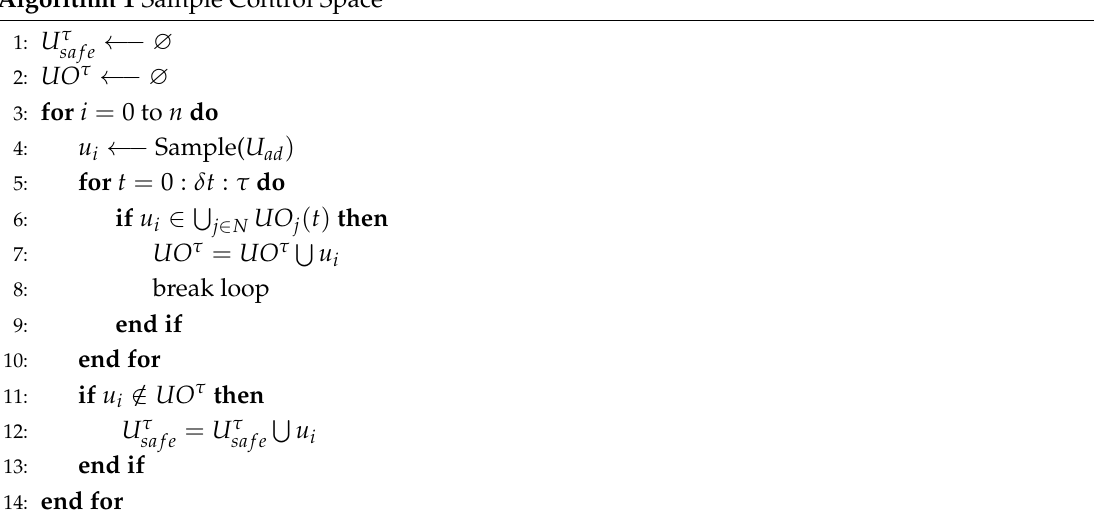
Algorithm 1 Sample Control Space